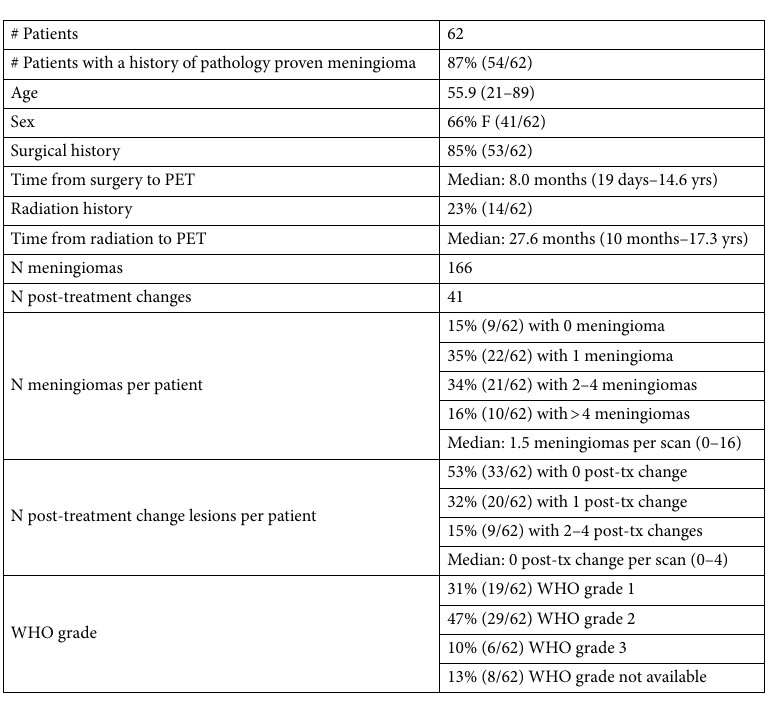
Table 1. Demographic characteristics of the study population.